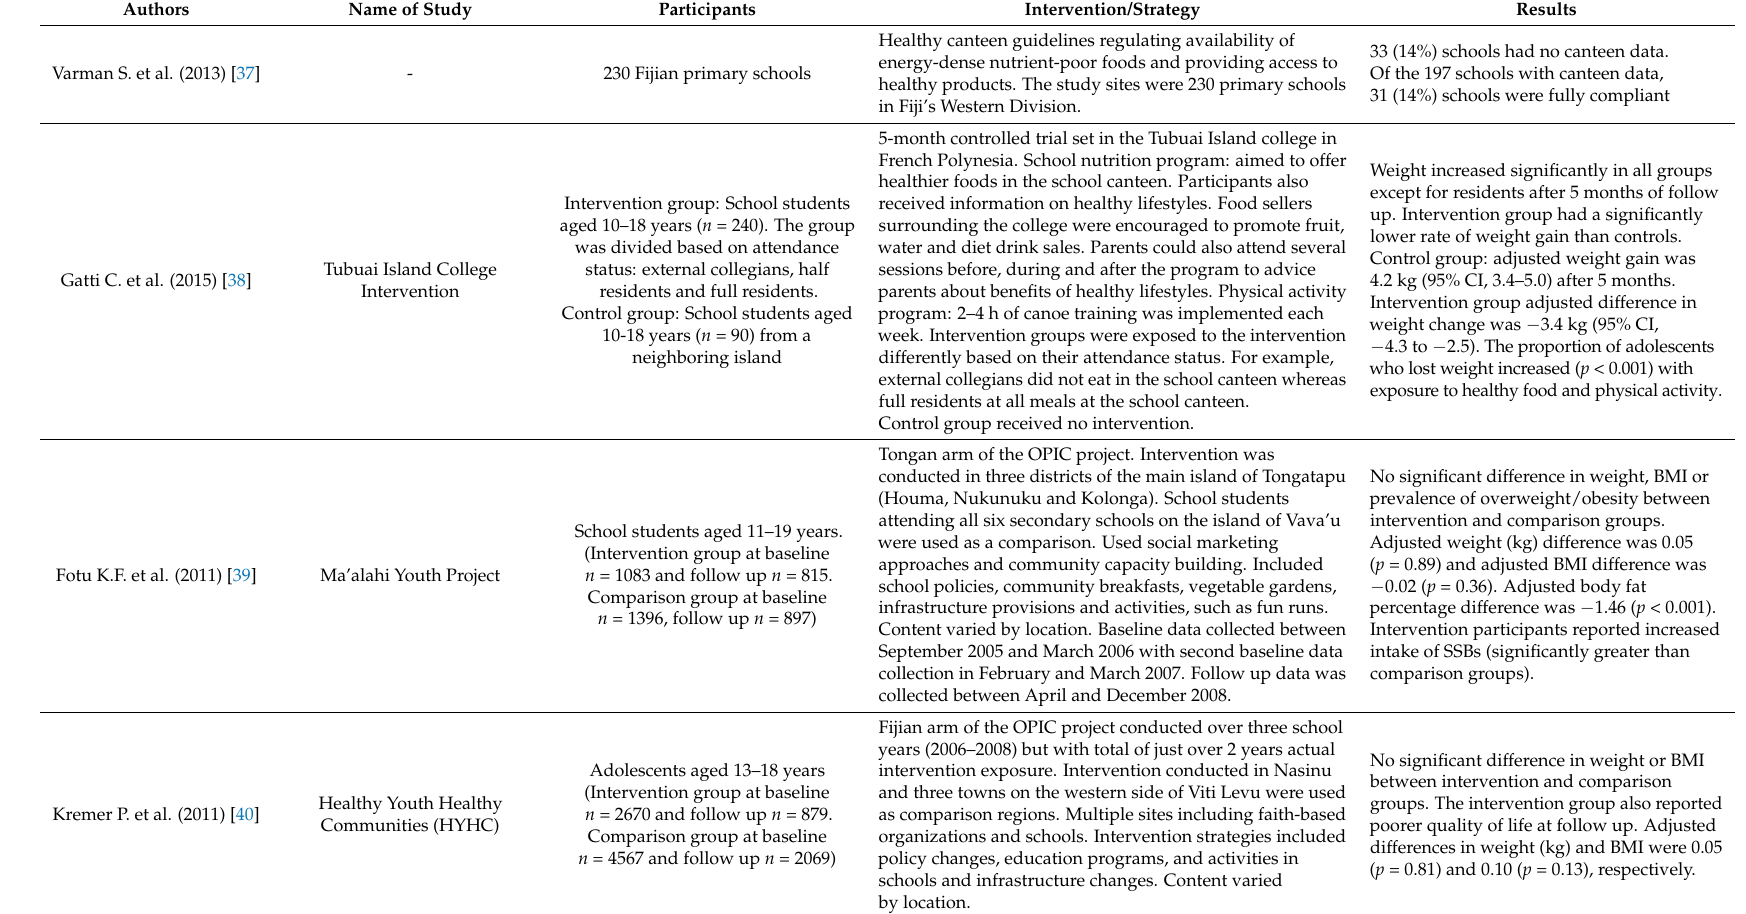
Table 2. Summary of identified school and community based programs among children and adolescents in the Pacific